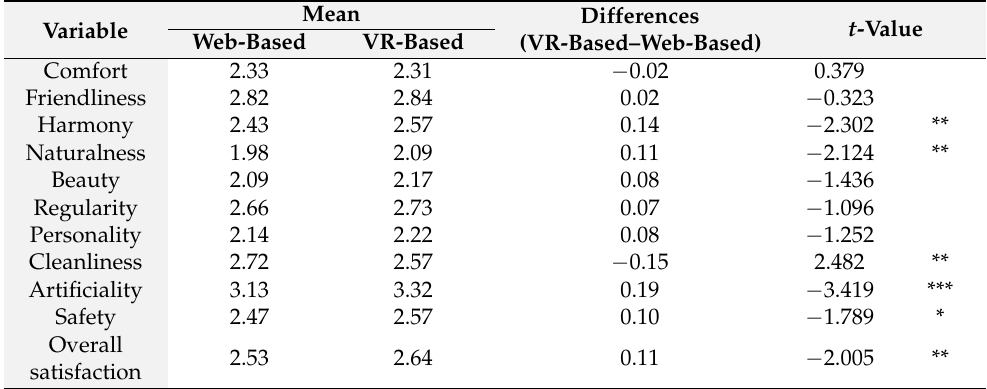
Table 3. t -tests of streetscape satisfaction differences between the web-based and VR-based